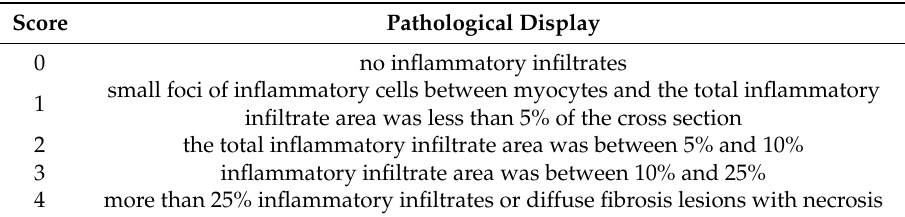
Table 1. The method for pathological